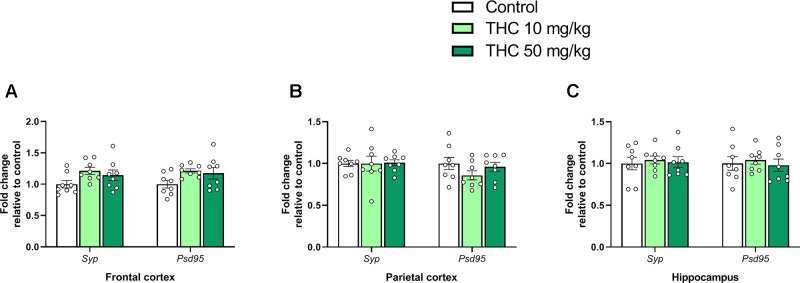
Synaptic density genes. Transcript levels of synaptic density gene markers Syp and Psd95 24 h after PND 10 exposure to vehicle, 10 mg THC/kg or 50 mg THC/kg in the (A) frontal cortex, (B) parietal cortex, and (C) hippocampus. Height of bars represents the mean fold change ± SEM of 8 mice.